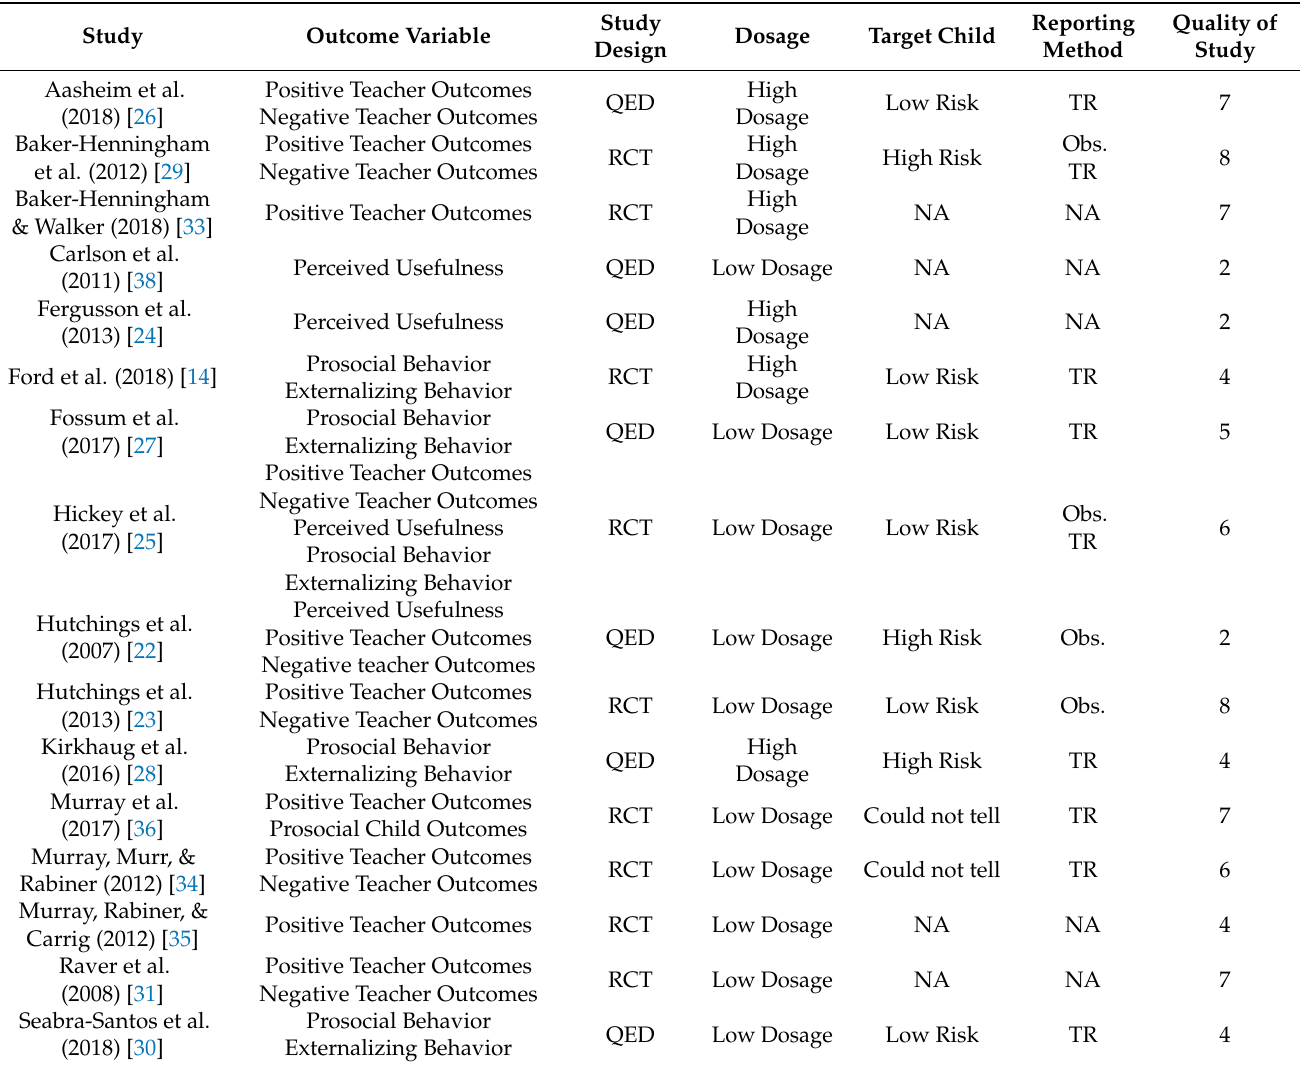
Table 1. Summary Characteristics of Teacher and Child Outcomes.